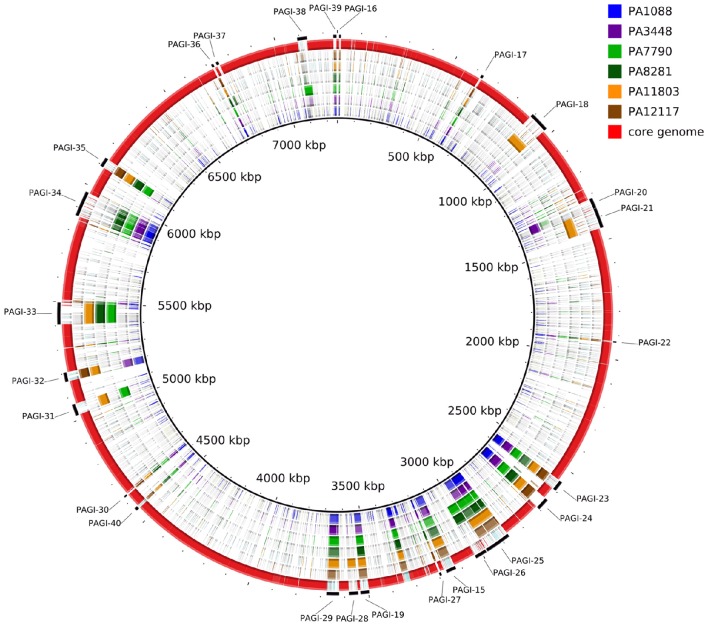
Circular map depicting the unique regions of each SPM-1-producing P. aeruginosa isolate relative to the reference strain PAO1. The red ring represents the core genome shared by all isolates. The outermost, interspaced ring represents the localization of the predicted genomic islands found in each isolate.